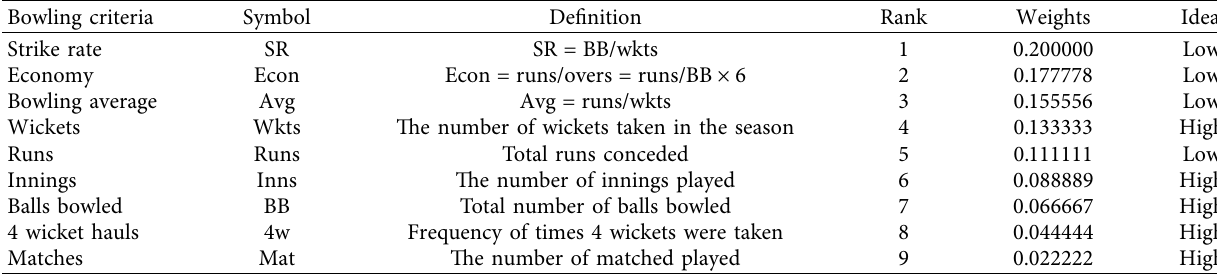
Table 2: Bowling performance criteria.